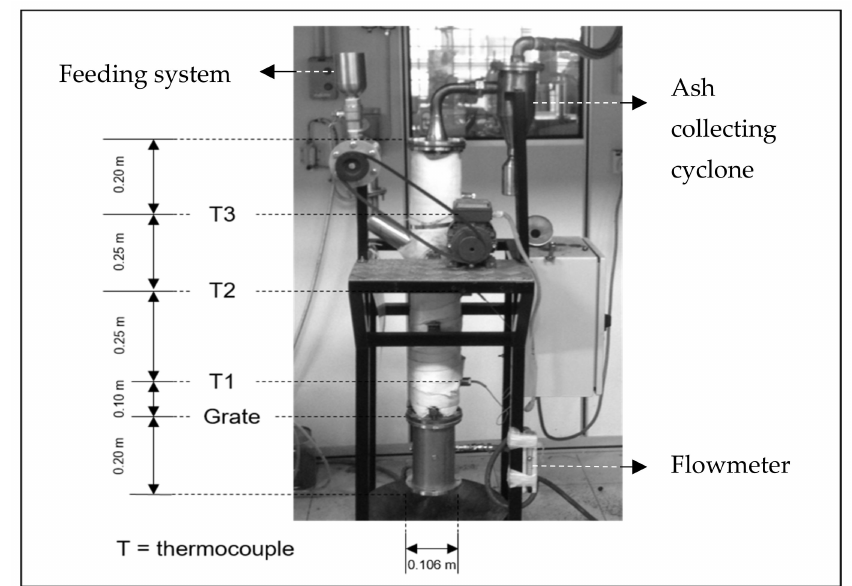
Figure 2. Picture of the experimental